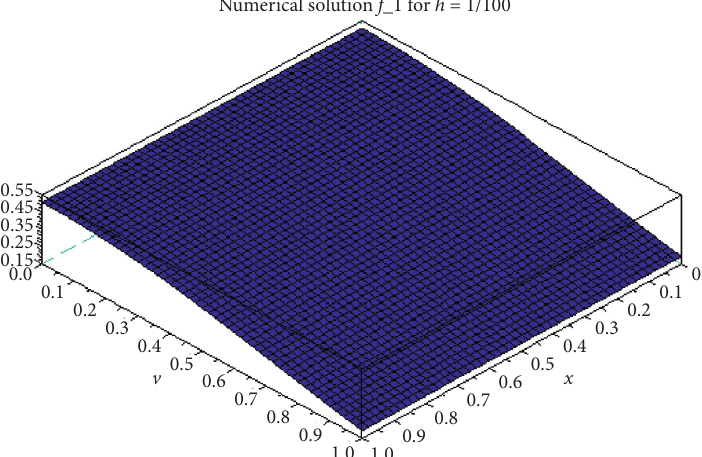
Figure 5: Numerical solution f 1/100